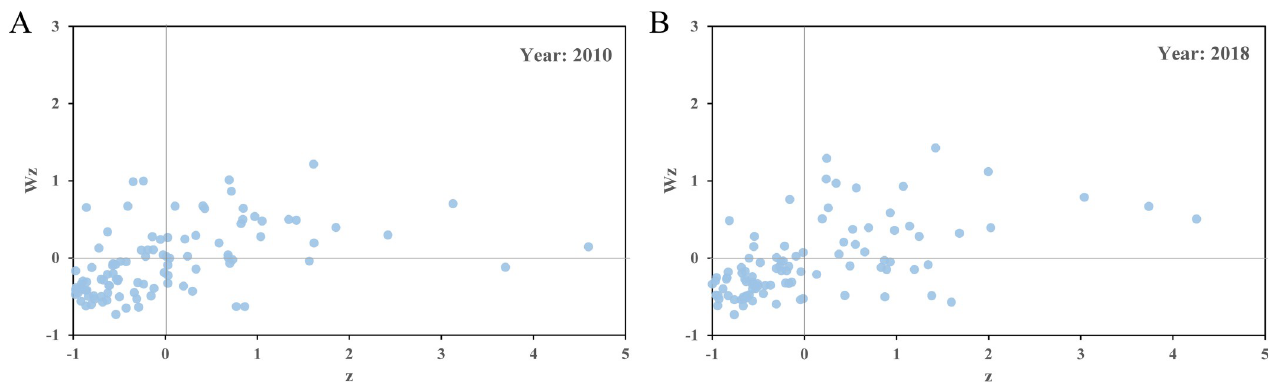
Fig 10. Moran scatter plot of per capita carbon emissions from civil buildings in Chinese cities in 2000 (A) and 2018 (B).